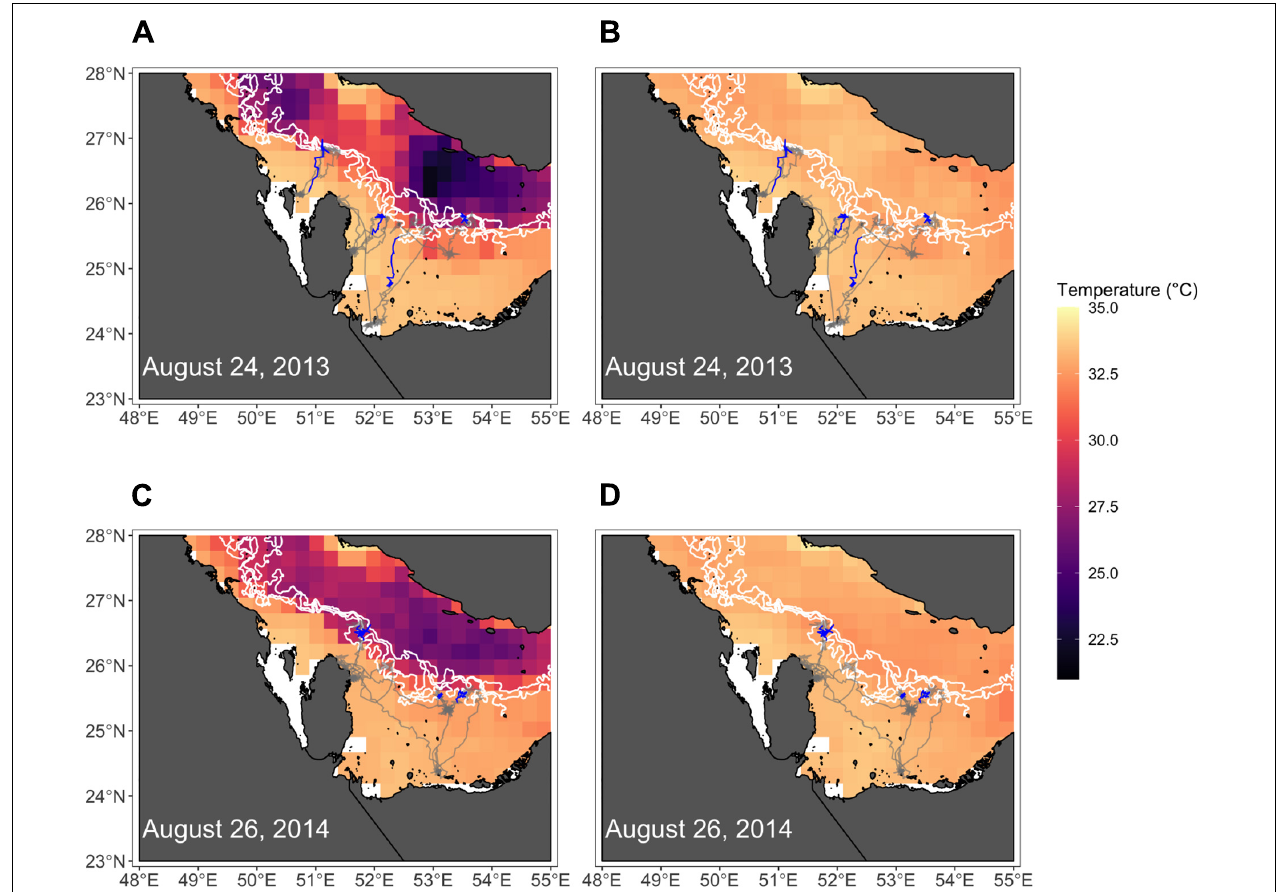
FIGURE 7 | Maps show positions of hawksbills near the peak of their migratory movements in each year where migrations were detected (2013, 2014). Bottom temperatures (A,C) and surface temperatures (B,D) are shown, where white lines denote the 30, 40, and 50 m isobaths. The entirety of hawksbill tracks for each year are shown, but only the relocations from the week of each date are highlighted